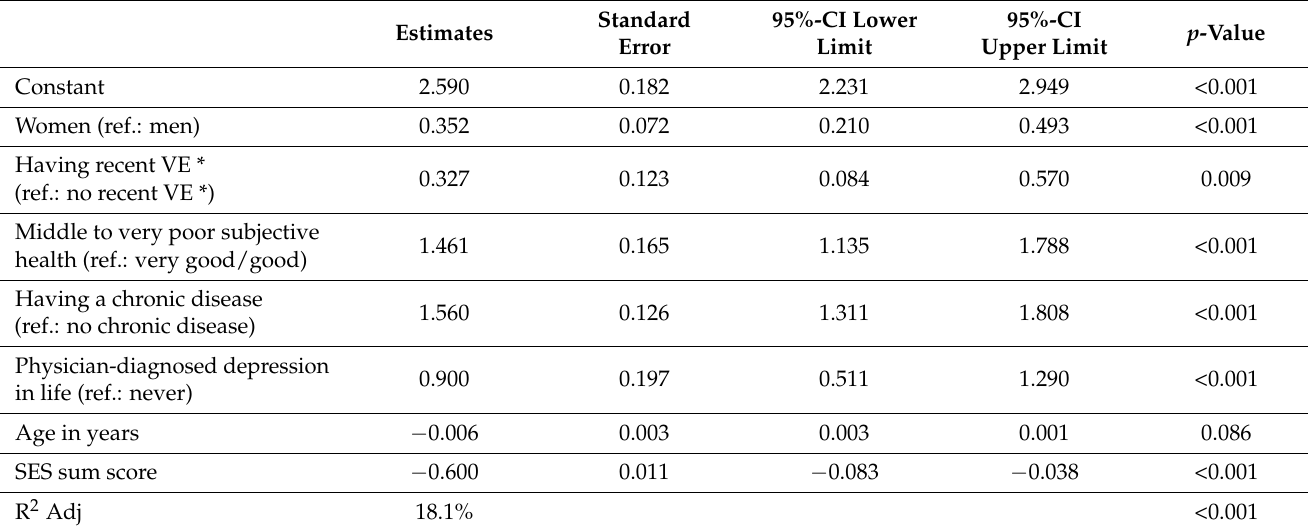
Table 3. DEGS1: Regression model regarding factors influencing GP contact in the last 12